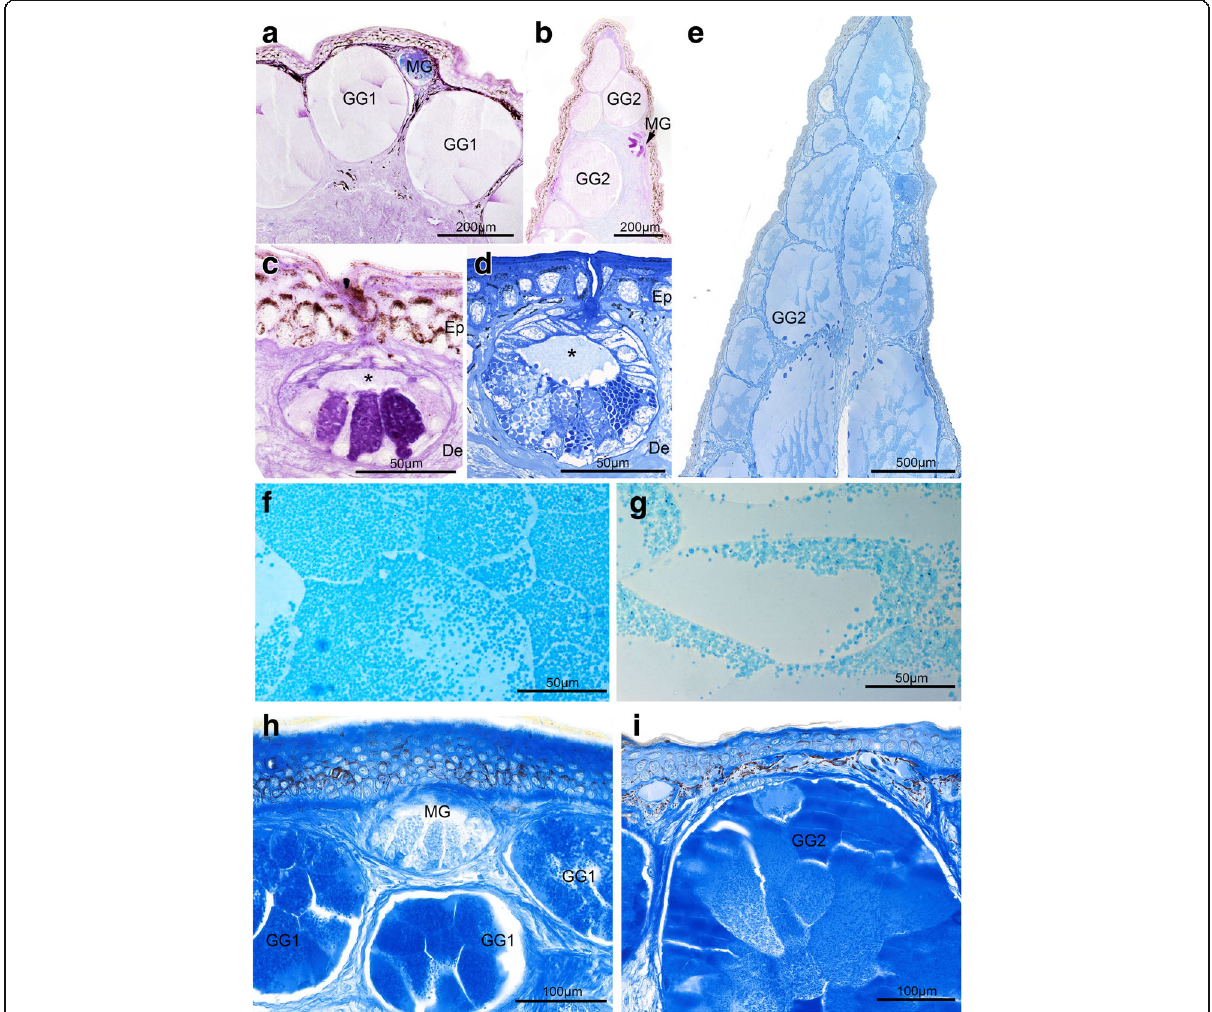
Fig. 2 Light micrographs of acinar dermal glands in the skin of T. verrucosus . a - c . Sections stained with Alcian blue at pH 2.5 and Periodic acid Schiff (AB-PAS) showing a the back region with large granular glands type 1 (GG1) extending deep into the dermis and a conspicuously smaller mucous gland (MG), b the dorsal tail edge with large granular glands type 2 (GG2) next to a MG and c details of a MG. Note that GG1s and GG2s neither react to the AB nor to the PAS test, while the MGs react both to AB and PAS (MG-lumen in C indicated by an asterisk). d-g . Toluidine blue stainings showing: d . Details of a MG with a central lumen (indicated by asterisk) surrounded by smaller cells in the apical half and large cells filled with secretory material in the basal half of the gland. e . Cross section through the dorsal tail edge, ca. 3 cm distal from the tail base showing the densely arranged giant granular glands type 2 (GG2). e and f . Details of GG1 ( e ) and GG2 ( f ) illustrating the differently arranged granules in the two gland types. H and I: Coomassie Brilliant Blue (CBB) stained sections from the lateral trunk ( h ) and ventral tail ( i ) showing positive CBB staining of GG1 ( h ) and GG2 ( i ) and negative CBB-reaction of MG ( h ). Ep, epithelium; De,